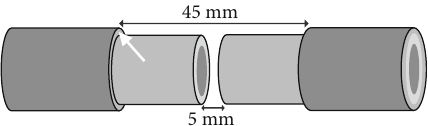
Figure 1: The design of each defect with massive periosteum loss. The periosteum (white arrow) was stripped totally 45 mm with one 5mm bone defect in the